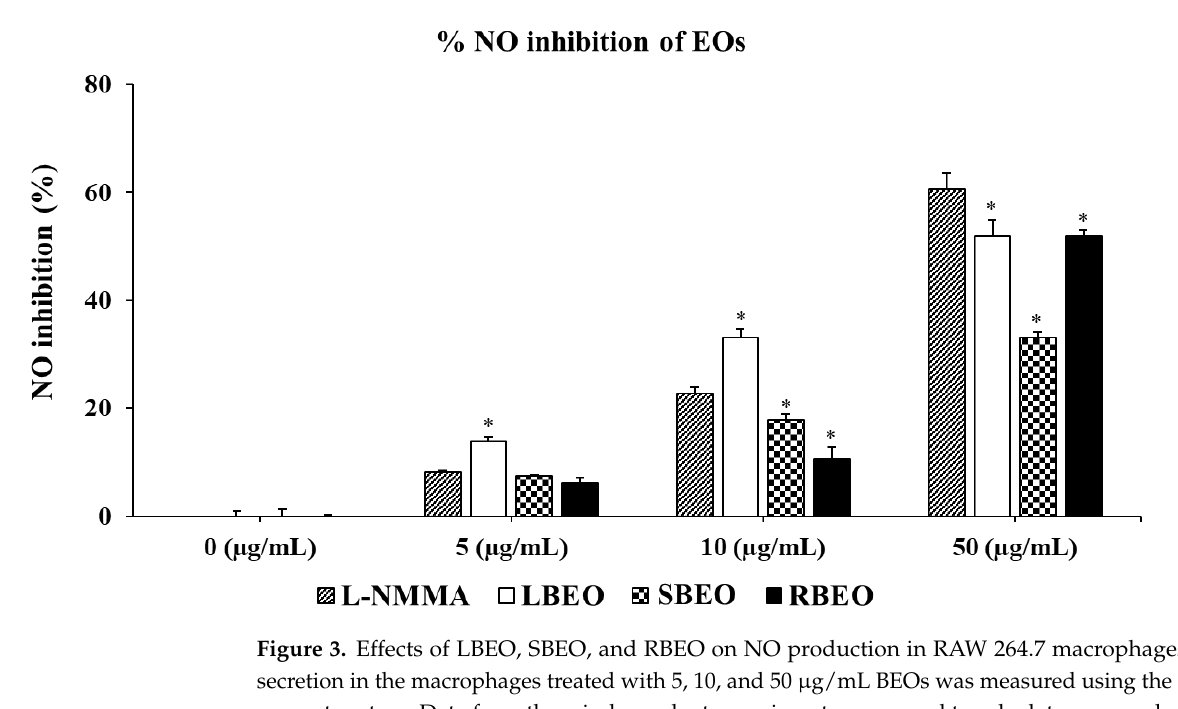
Figure 3. Effects of LBEO, SBEO, and RBEO on NO production in RAW 264.7 macrophages. NO secretion in the macrophages treated with 5, 10, and 50 µg/mL BEOs was measured using the Griess reagent system. Data from three independent experiments were used to calculate mean values and standard deviation * p < 0.01 vs. positive control group (L-NMMA).